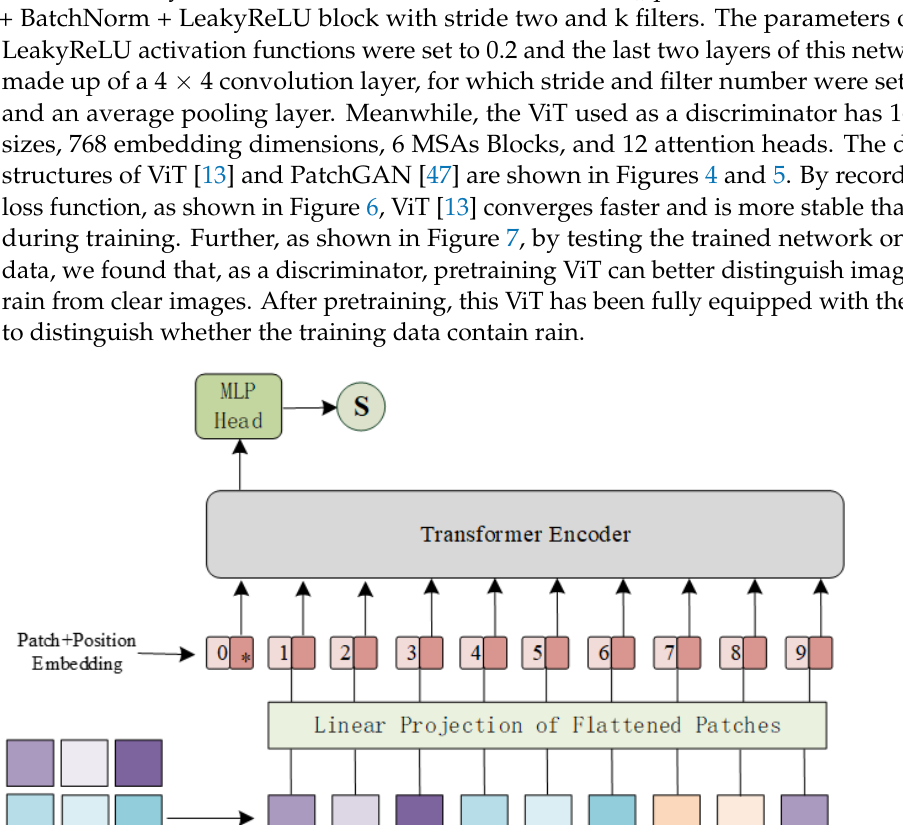
7 of 17 Figure 3. Numerical comparison of three losses during model training. 2.2. Discriminator: Pretrained ViT Due to their capacity for long-range representation [40] and faculty for flattening loss landscapes [30], transformer-based models show high performance for visual tasks with less need for vision-specific induction [31]. Multiple tasks [41–43] have revealed that trans- former-based models heavily rely on massive datasets for large-scale training, which may be the key to achieving its inductive bias [13]. However, pretraining [44] on large-scale datasets (e.g., ImageNet [45]) is both very demanding on hardware and does not neces-